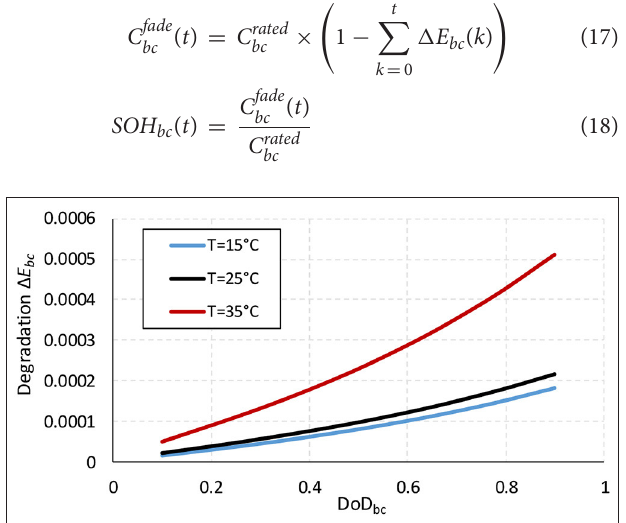
FIGURE 3 | Battery degradation vs. DoD curve under different operating